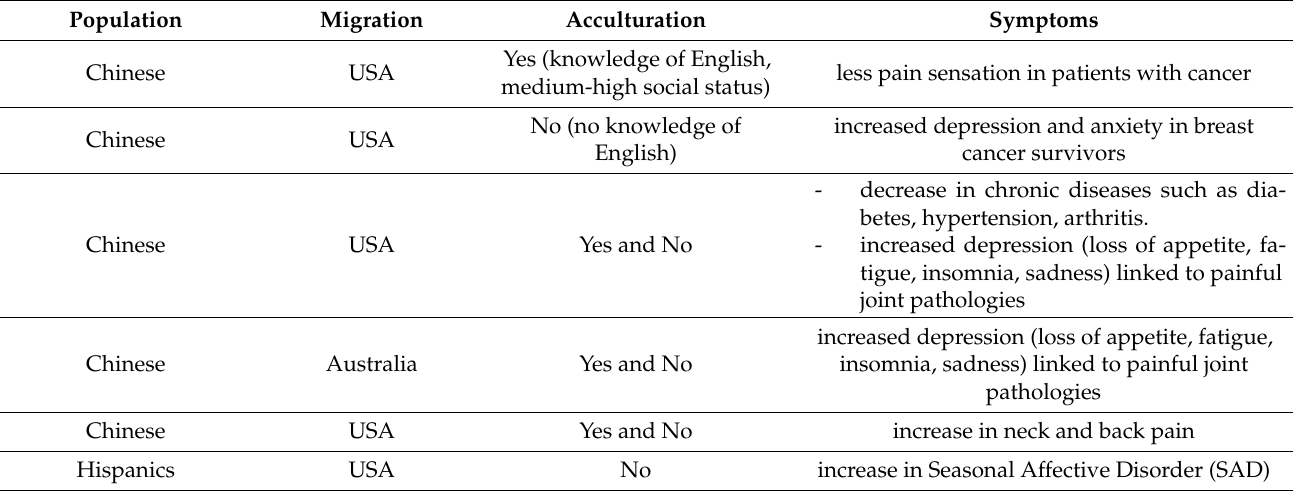
Table 1. Characteristics of populations cited in the studies are